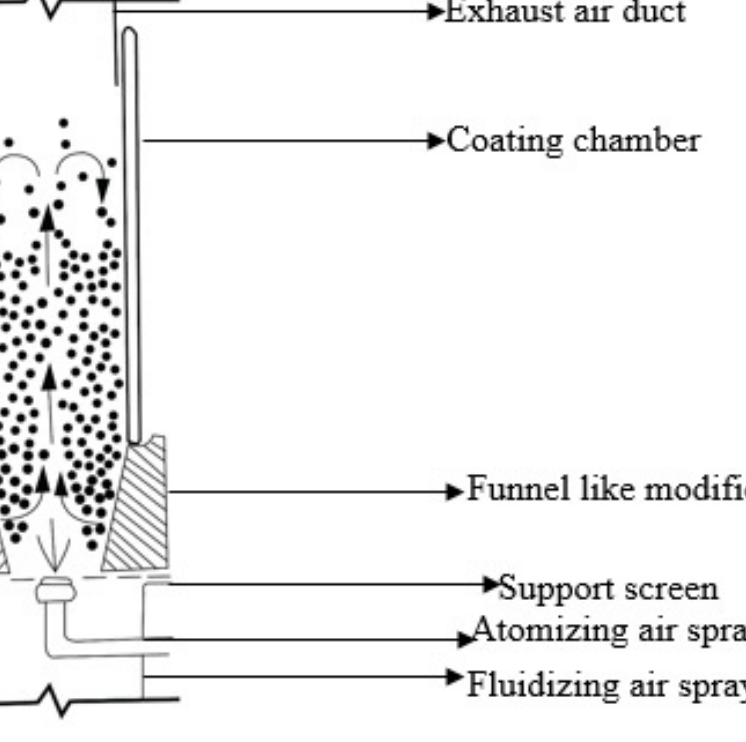
Figure 14. Represen ts fluidized bed coating system. Figure 14. Represents fluidized bed coating